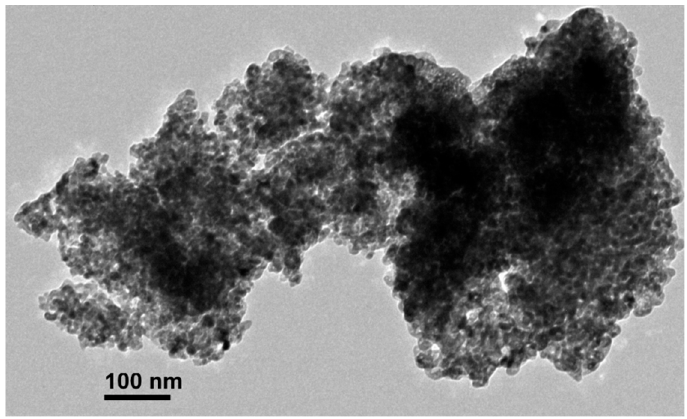
Figure 2. TEM image of PB nanoparticles.